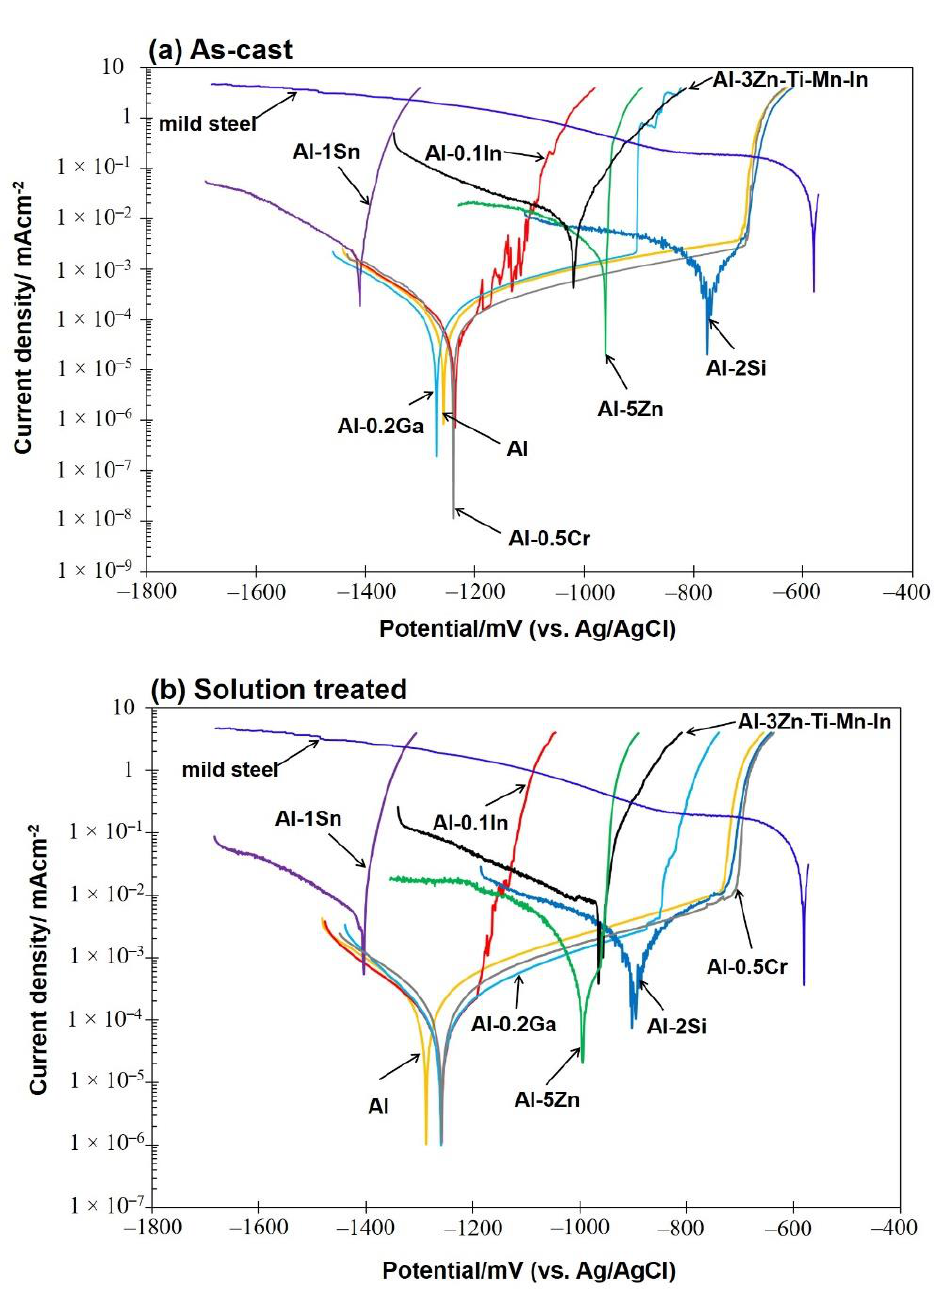
Figure 6. Potentiodynamic polarisation measurements of as-cast ( a ) and solution-treated ( b ) Al-based alloys and mild steel.